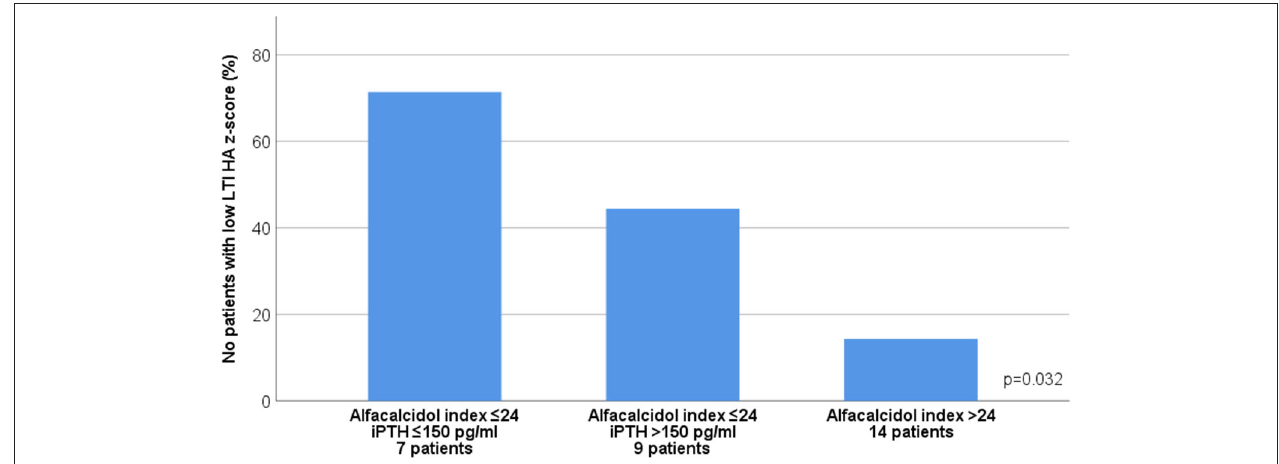
FIGURE 5 | Association between 6-month mean alfacalcidol index ([mcg/week per pg/ml of iPTH] × 1000) and low lean tissue index adjusted to height-age z-score (LTI-HA) (LTI HA z-score < − 1.65) after stratification by 6-month mean serum intact parathormone (iPTH) levels in chronic kidney disease (CKD) stages 4-5D patients.